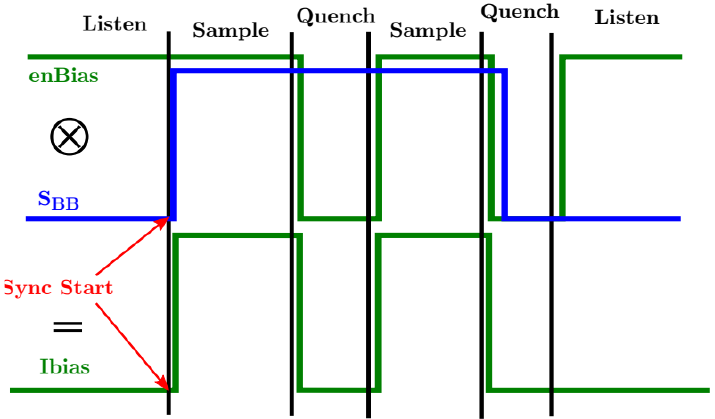
Figure 12. Sketched timing diagram to the idea of a synchronized quench control.